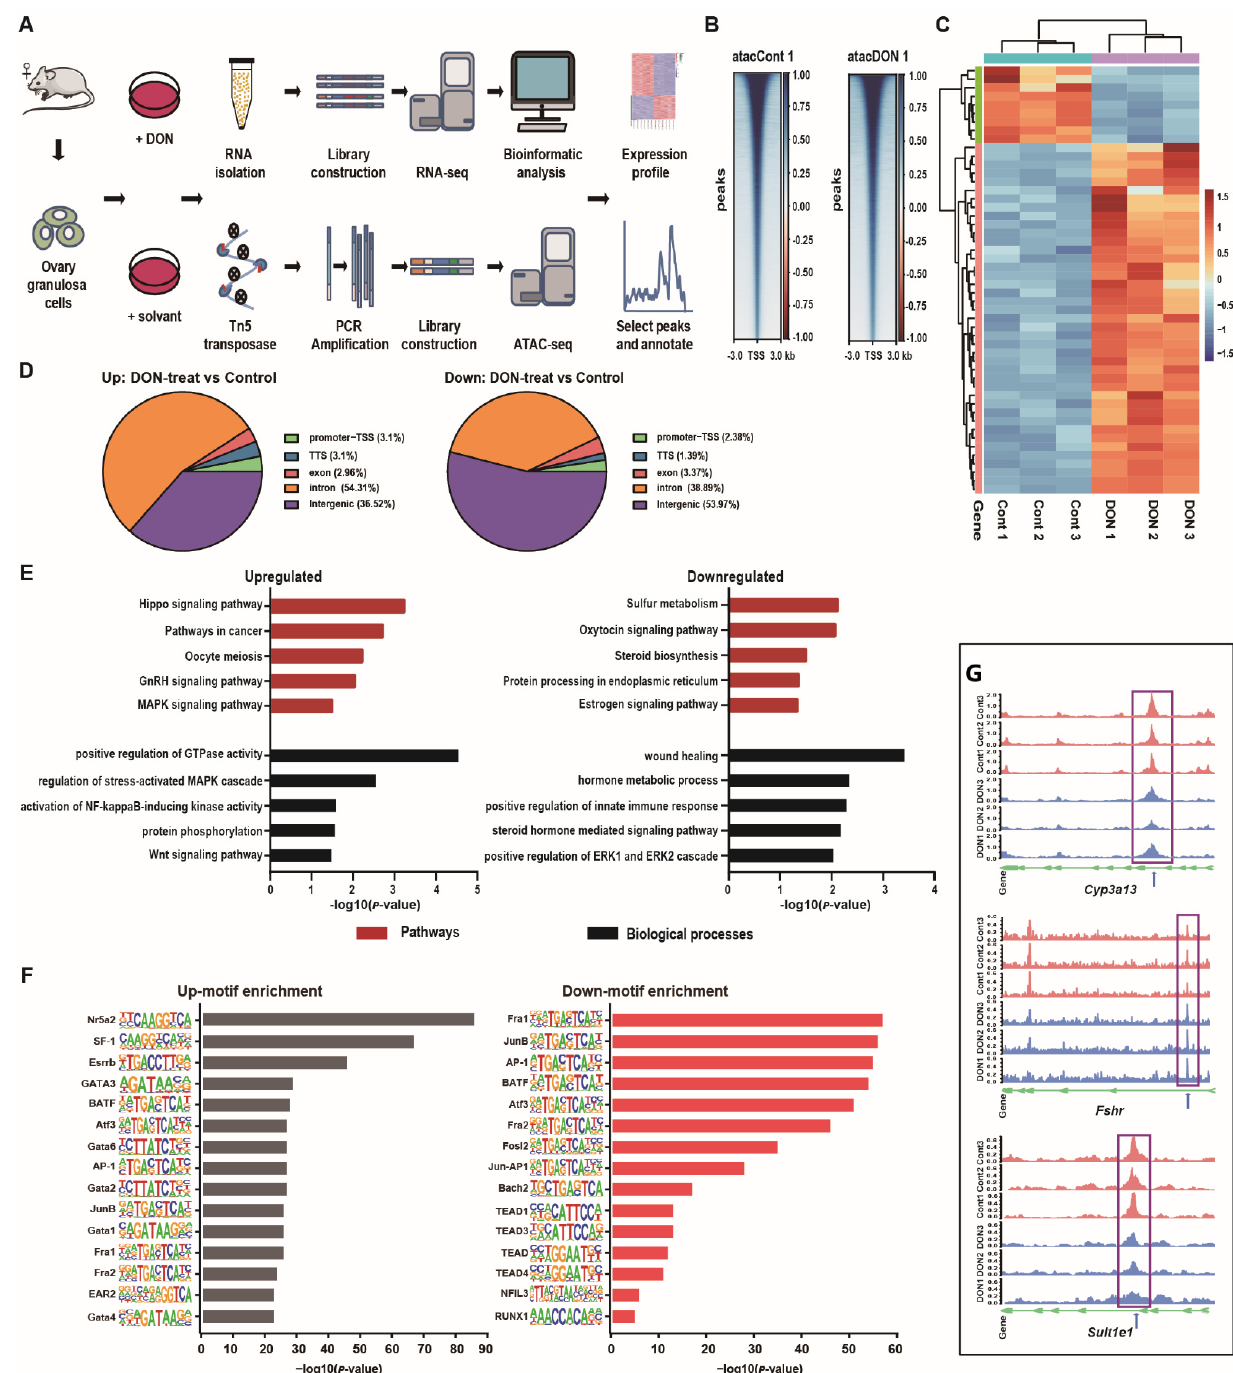
Figure 2. ATAC-seq data quality metrics and pathway analysis. ( A ) Overview of the experimental and data analysis workflow. ( B ) The ATAC-seq signal enrichment around the transcription start sites (TSSs) of DON-treated and control group. ( C ) Hierarchical clustering of peak enrichment patterns between DON-treated and control groups. ( D ) The genome-wide distribution of the peaks. The genome-wide functional regions were divided into promoter, downstream TTS, coding exon, intron, and distal intergenic regions. ( E ) Signaling pathway associated with chromatin accessibility in ovarian GCs upon DON exposure. ( F ) The top 15 of upregulated and downregulated motif enrichment. ( G ) Tracks for DON-treated samples at the Cyp3a13, Fshr, and Sult1e1 genes with predicted AP-1 binding sites. The predicted AP-1 binding sites are shown with a blue